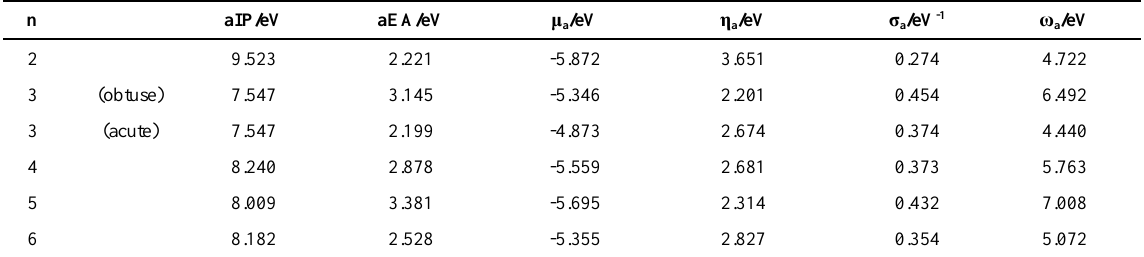
Table 4. Scalar-relativistic adiabatic ionization potential (aIP/eV), adiabatic electron affinity (aEA/eV), adiabatic chemical potential (μ a /eV), adiabatic hardness (η a /eV), adiabatic softness (σ a /eV -1 ) and adiabatic electrophilicity index (ω a /eV) n